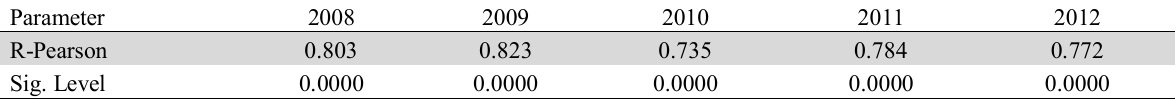
Correlation Analysis of free cash flow and firm value